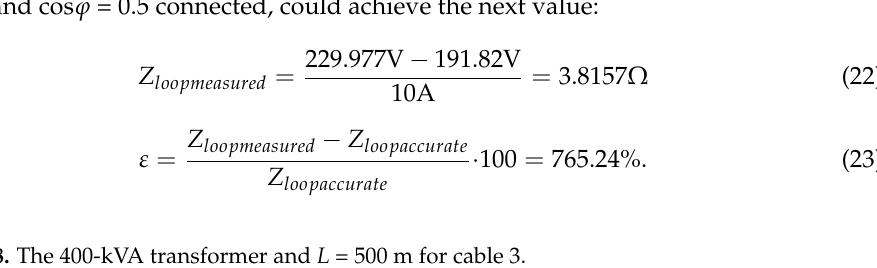
Table 8. The 400-kVA transformer and L = 500 m for cable